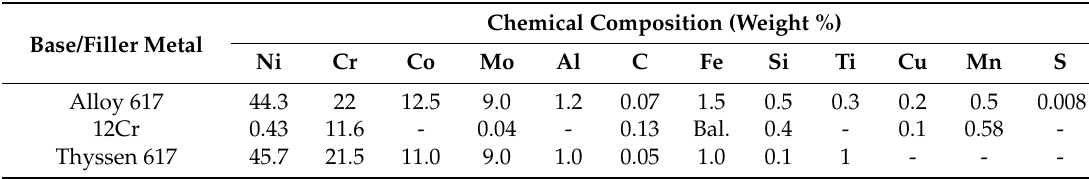
Table 2. Chemical composition of alloy 617, Thyssen 617, and 12Cr